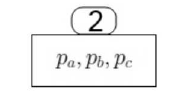
Figure 4. Final model (model after the lack of reaction to the father’s second